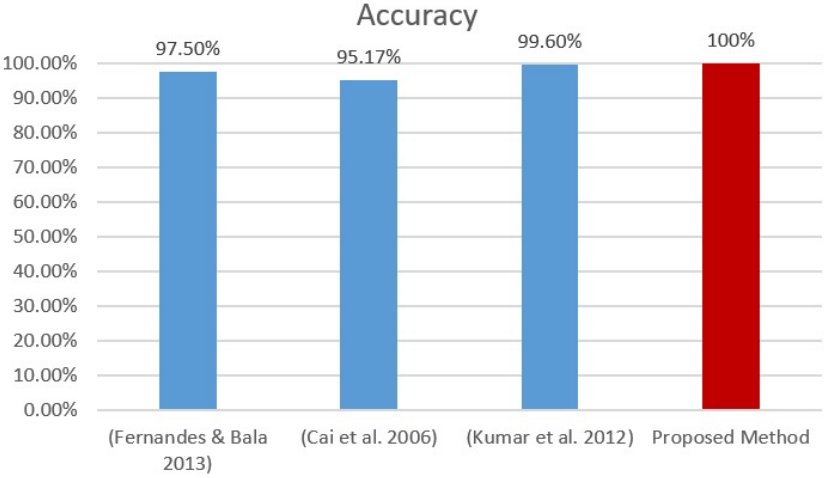
Figure 14. Accuracy analysis for Extended Yale-B database [14,33,34].